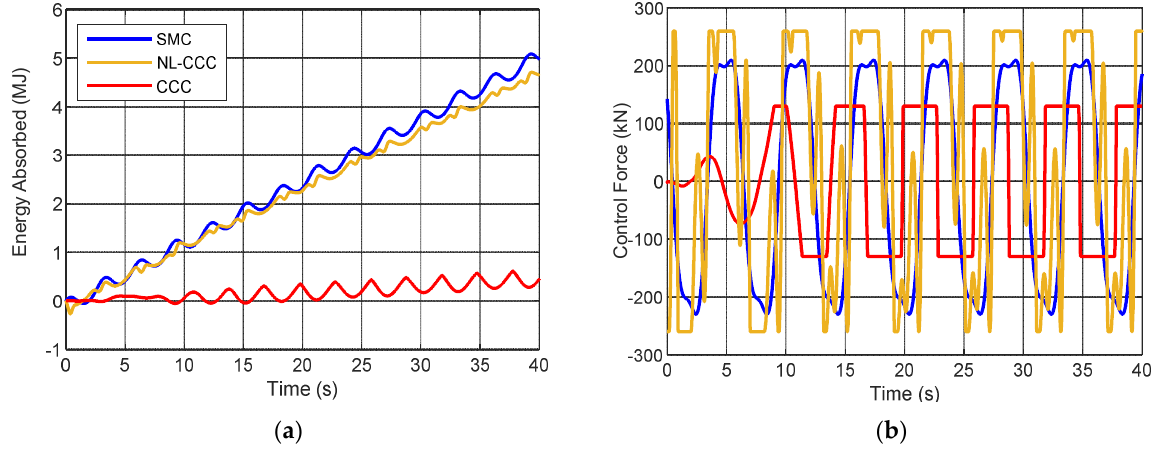
Figure 6. Absorbed energy ( a ) and control force ( b ) when implementing SMC, NL−CCC and CCC at T = 6 s.